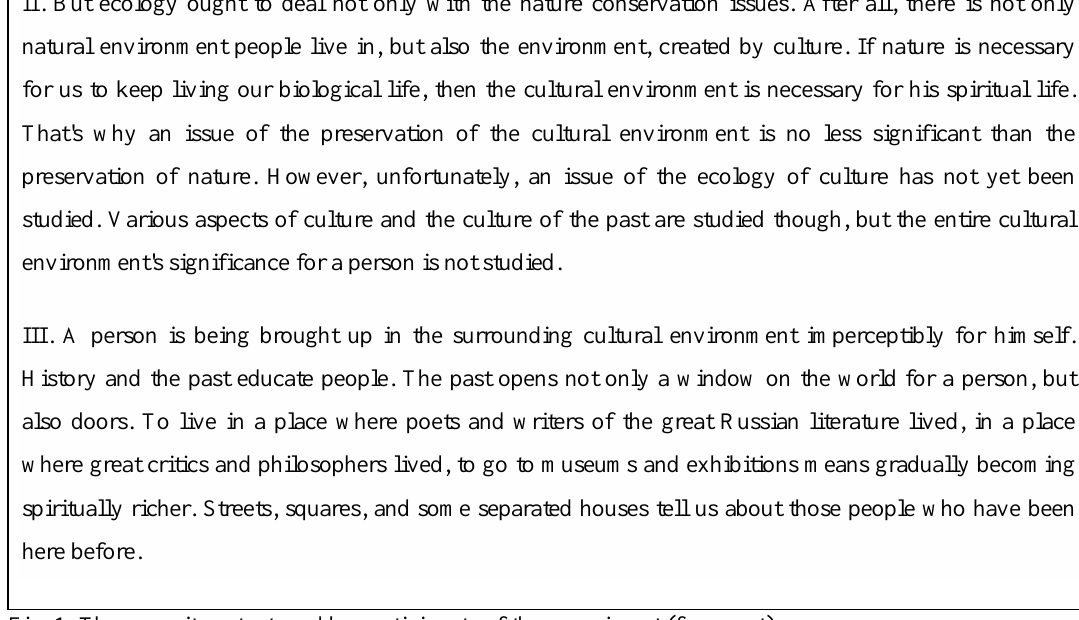
Fig. 1. The expository text read by participants of the experiment (fragment) Text readability parameters measured with Rulingva report the text to correspond cognitive and linguistic